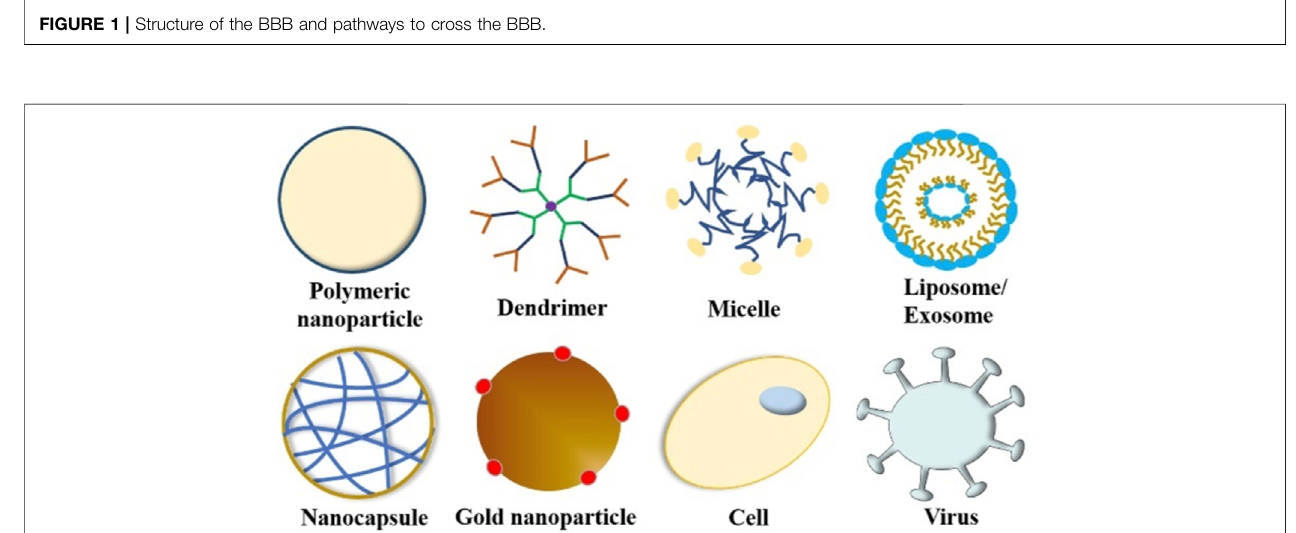
FIGURE 2 | Nanocarriers for drug